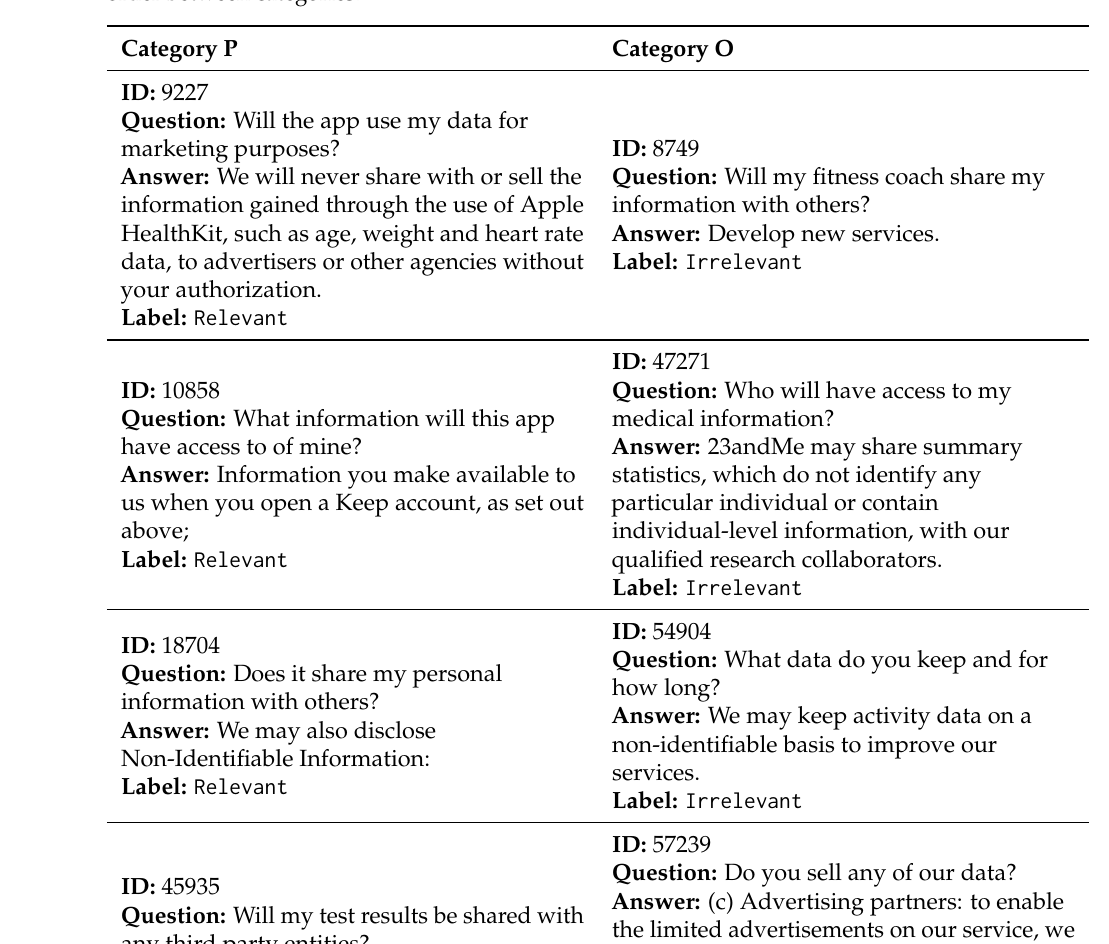
Table A4. Additional test-set examples from PrivacyQA that fall under categories P and O for PrivBERT vs. BERT; note that these examples are not paired and can therefore be compared in any order between